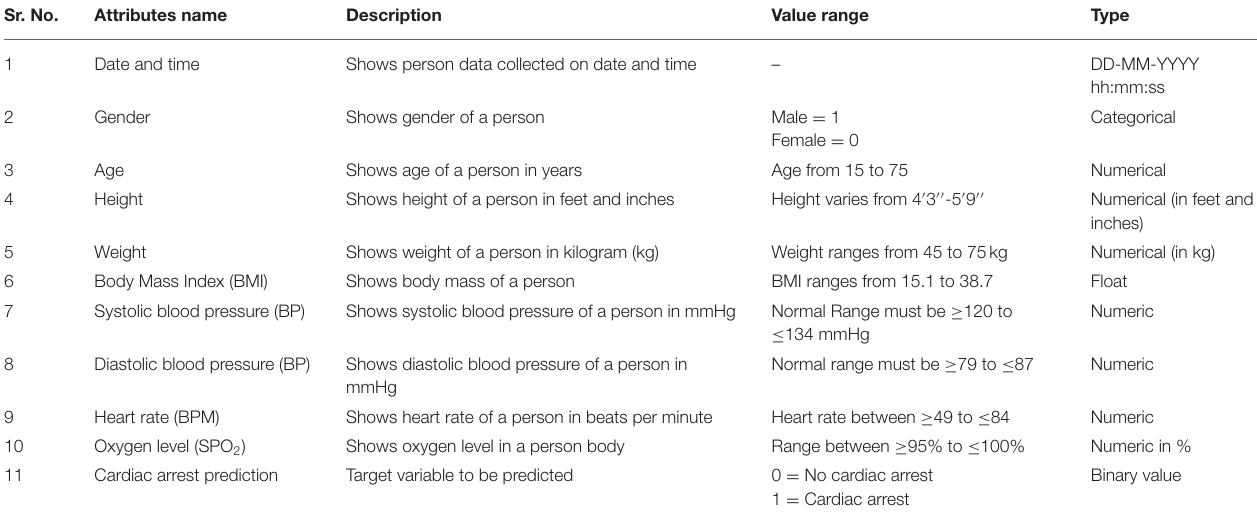
TABLE 2 | Dataset description. Sr. No.